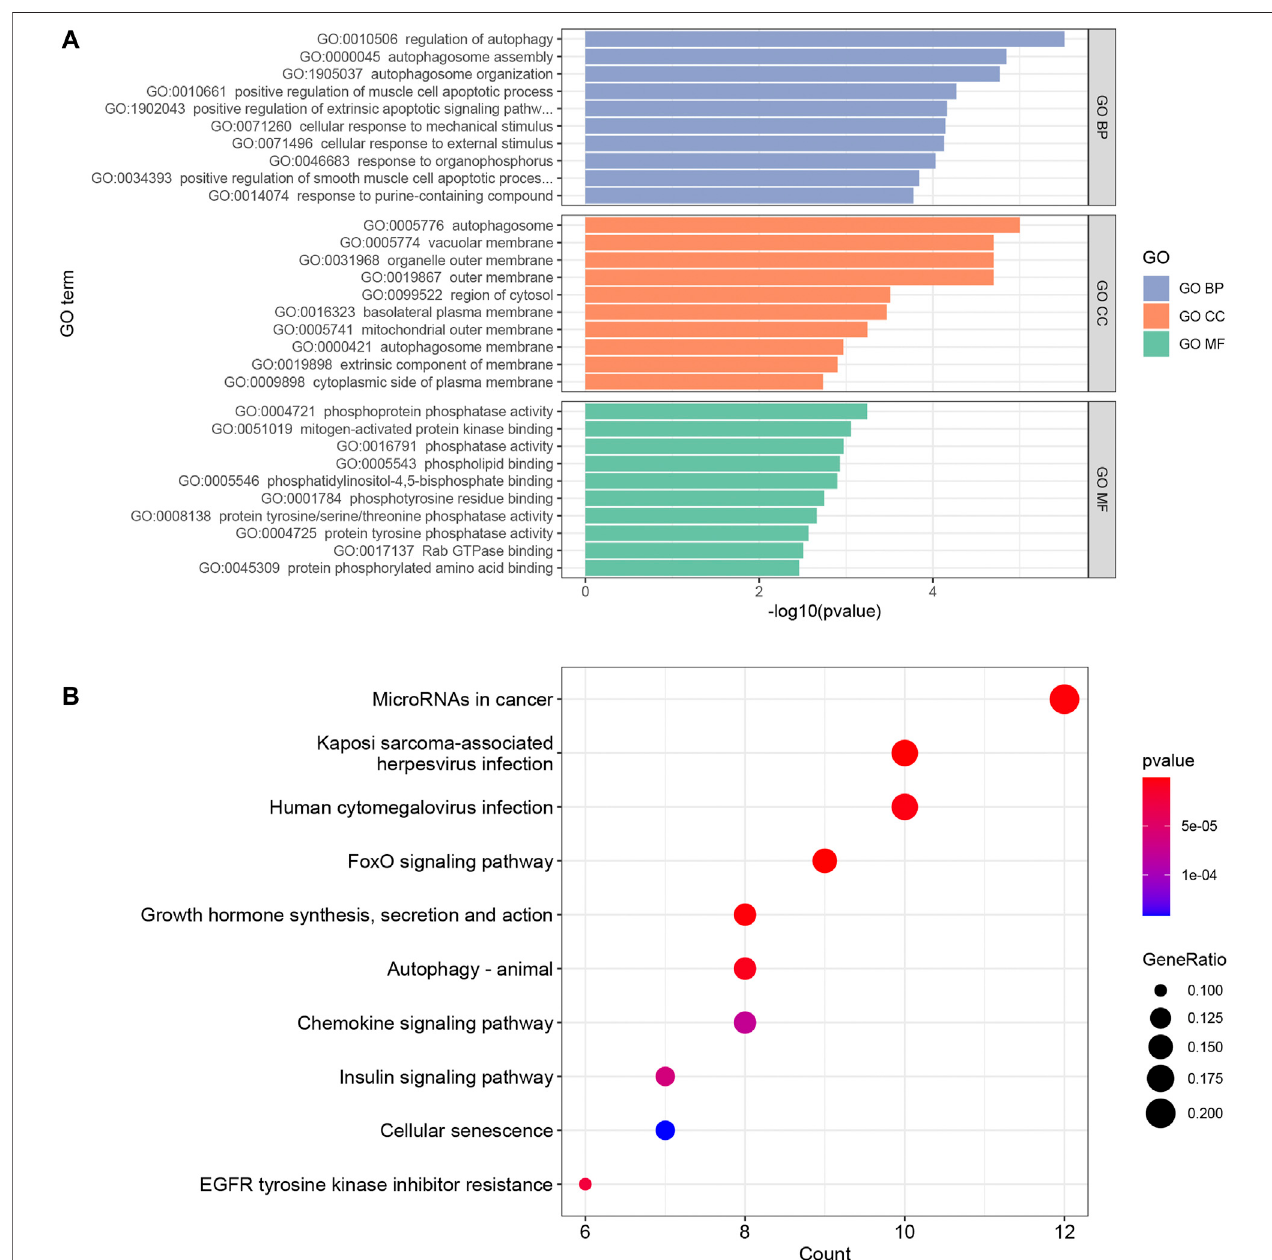
FIGURE 4 | The results of top 10 GO terms (A) and KEGG pathway enrichment analysis (B) in the ceRNA network. p value < 0.05 and an enrichment number of at least 3 were considered to be signi fi cant.